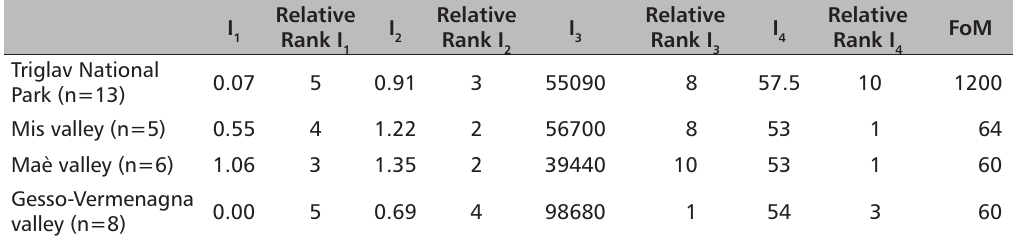
TABle 8. Results of figure of merit (FoM) for forest biomass harvesting by case study